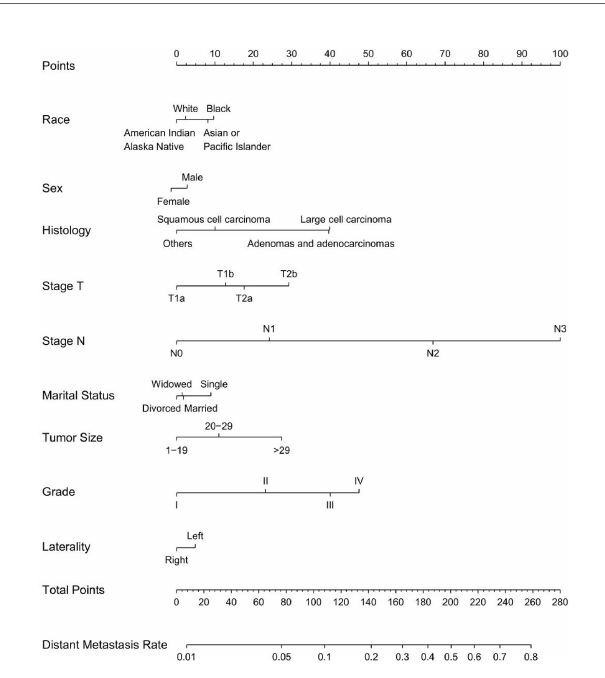
FIGURE 5 | Nomogram for predicting DM in T1-2N0-3M0-1 NSCLC. Nine factors were calculated into DM prediction